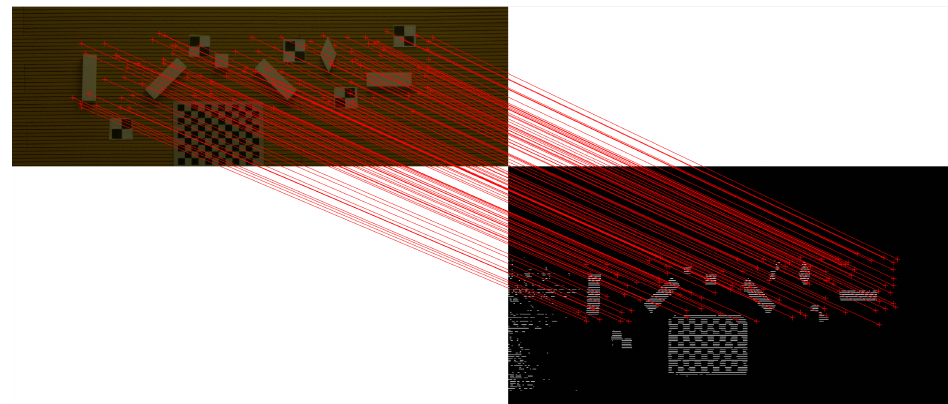
Figure 12. Distribution of the point pairs for calibration in the camera image and LiDAR image.